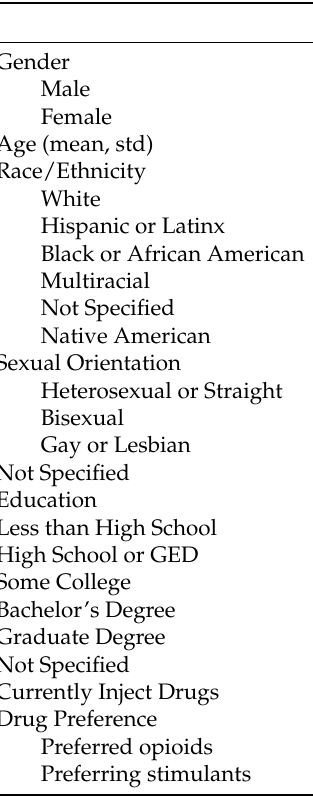
Table 1. Characteristics of People Who Inject Drugs (n =